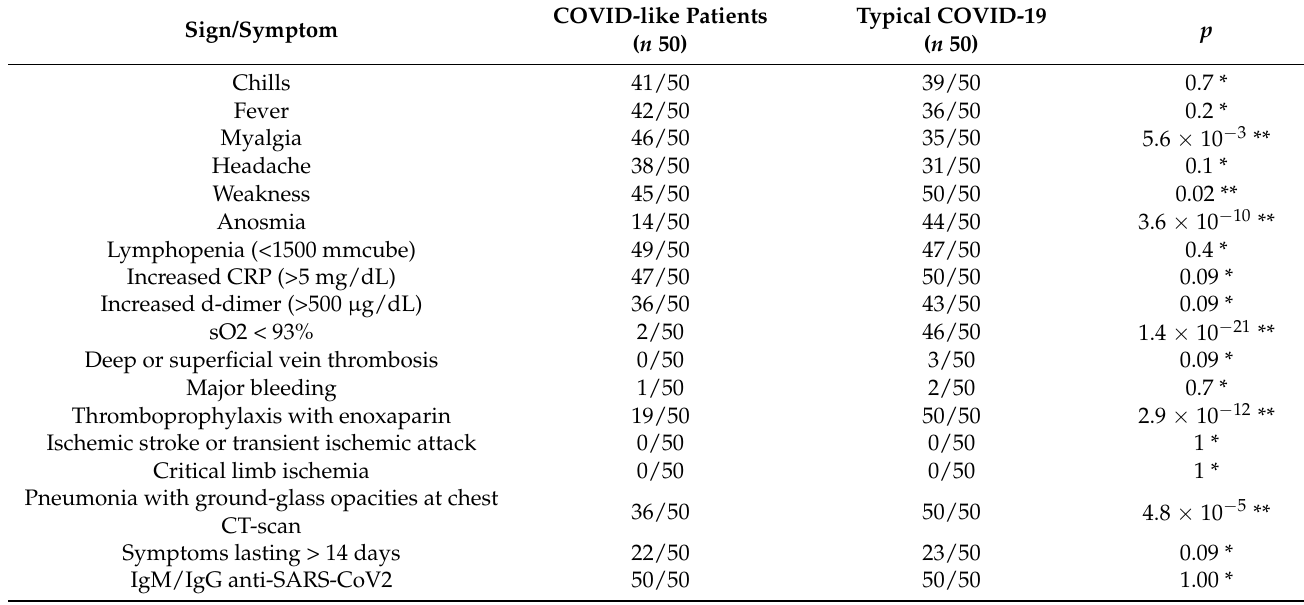
Table 1. Clinical characteristics of patients with COVID-like syndrome and typical COVID-19.